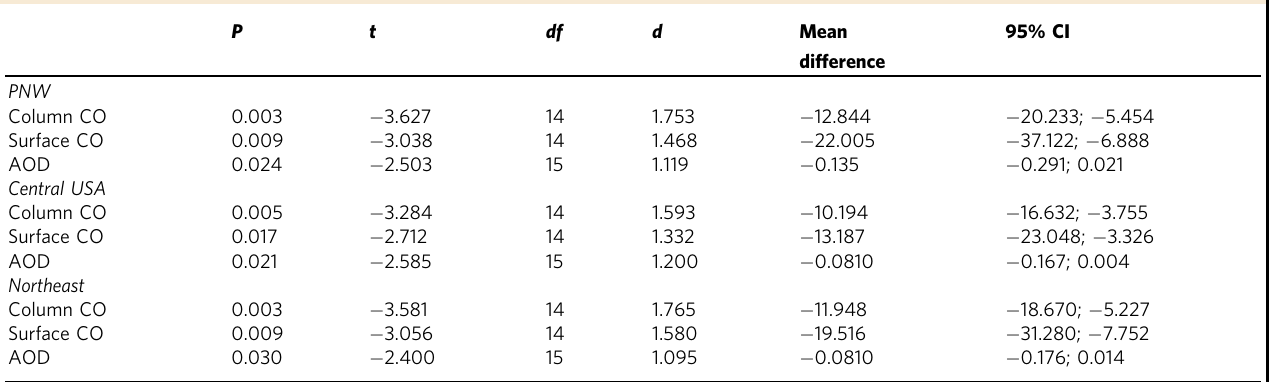
Table 1 August comparison statistics between 2002 – 2011 and 2012 – 2018 mean atmospheric composition, for the three regions of interest from an independent, two-tailed t -test, for α = 0.05.